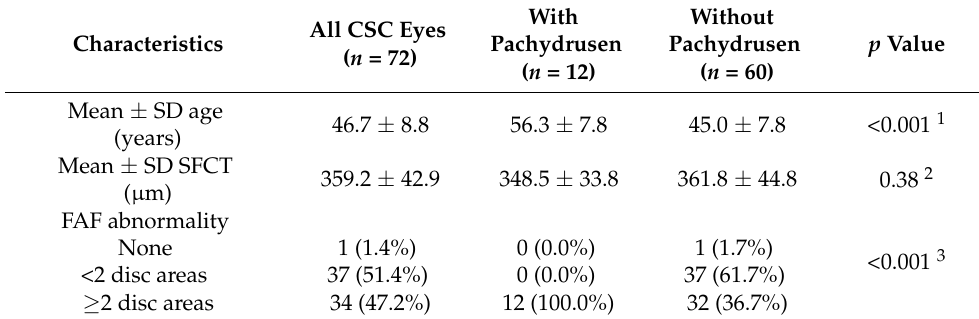
Table 1. Characteristics of CSC eyes with or without pachydrusen.